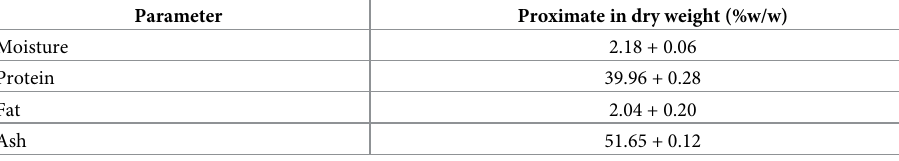
Table 1. Principal contents of salmon bone powder.